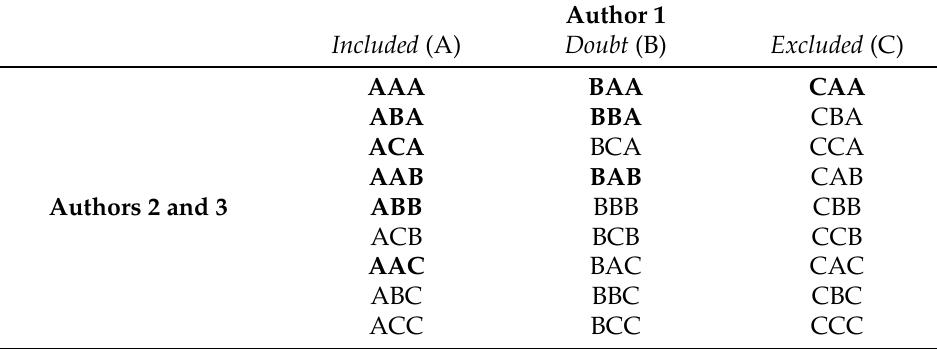
Table 3. Decision rules (included in